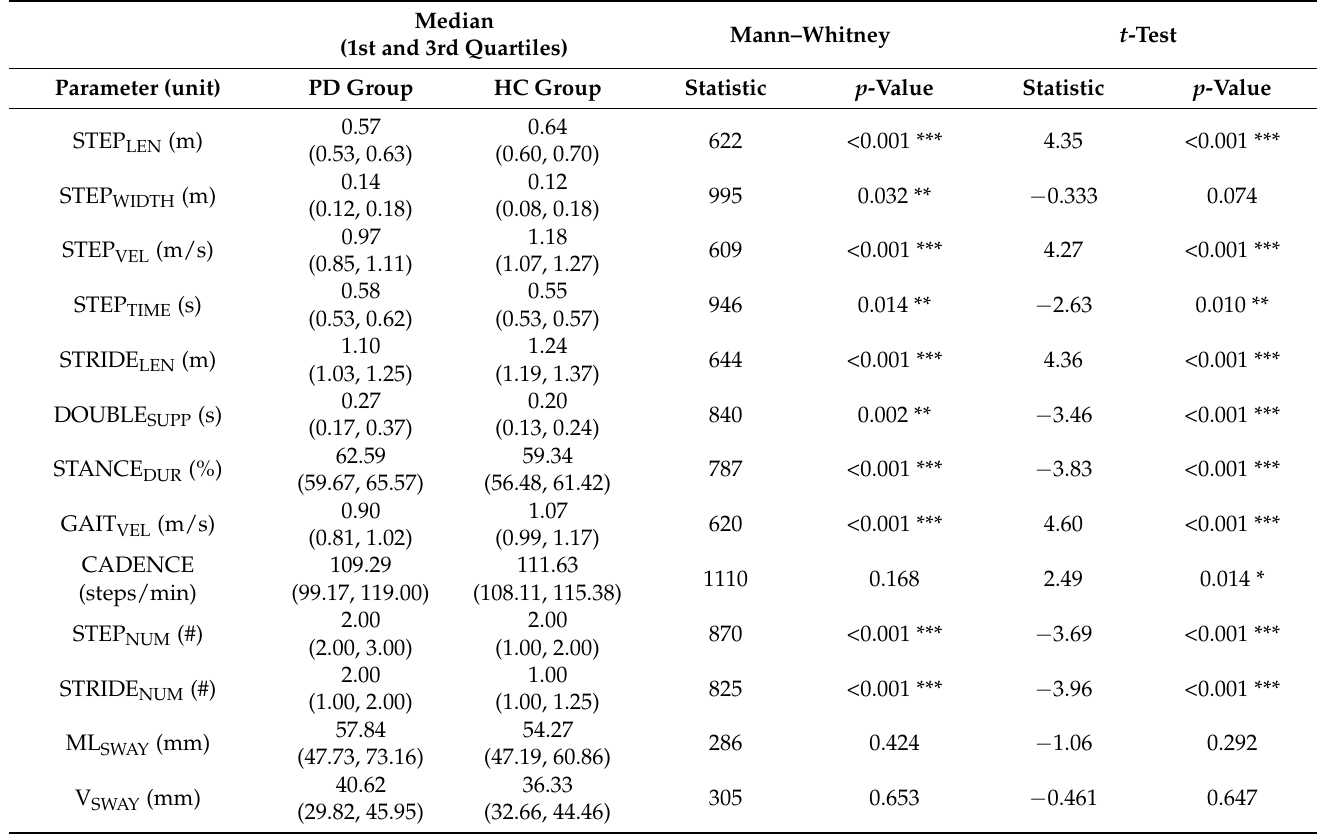
Table 4. Median and quartiles (first and third) relative to spatiotemporal and COM parameters for PD and HC groups, with test statistic, p -value, and significance level.